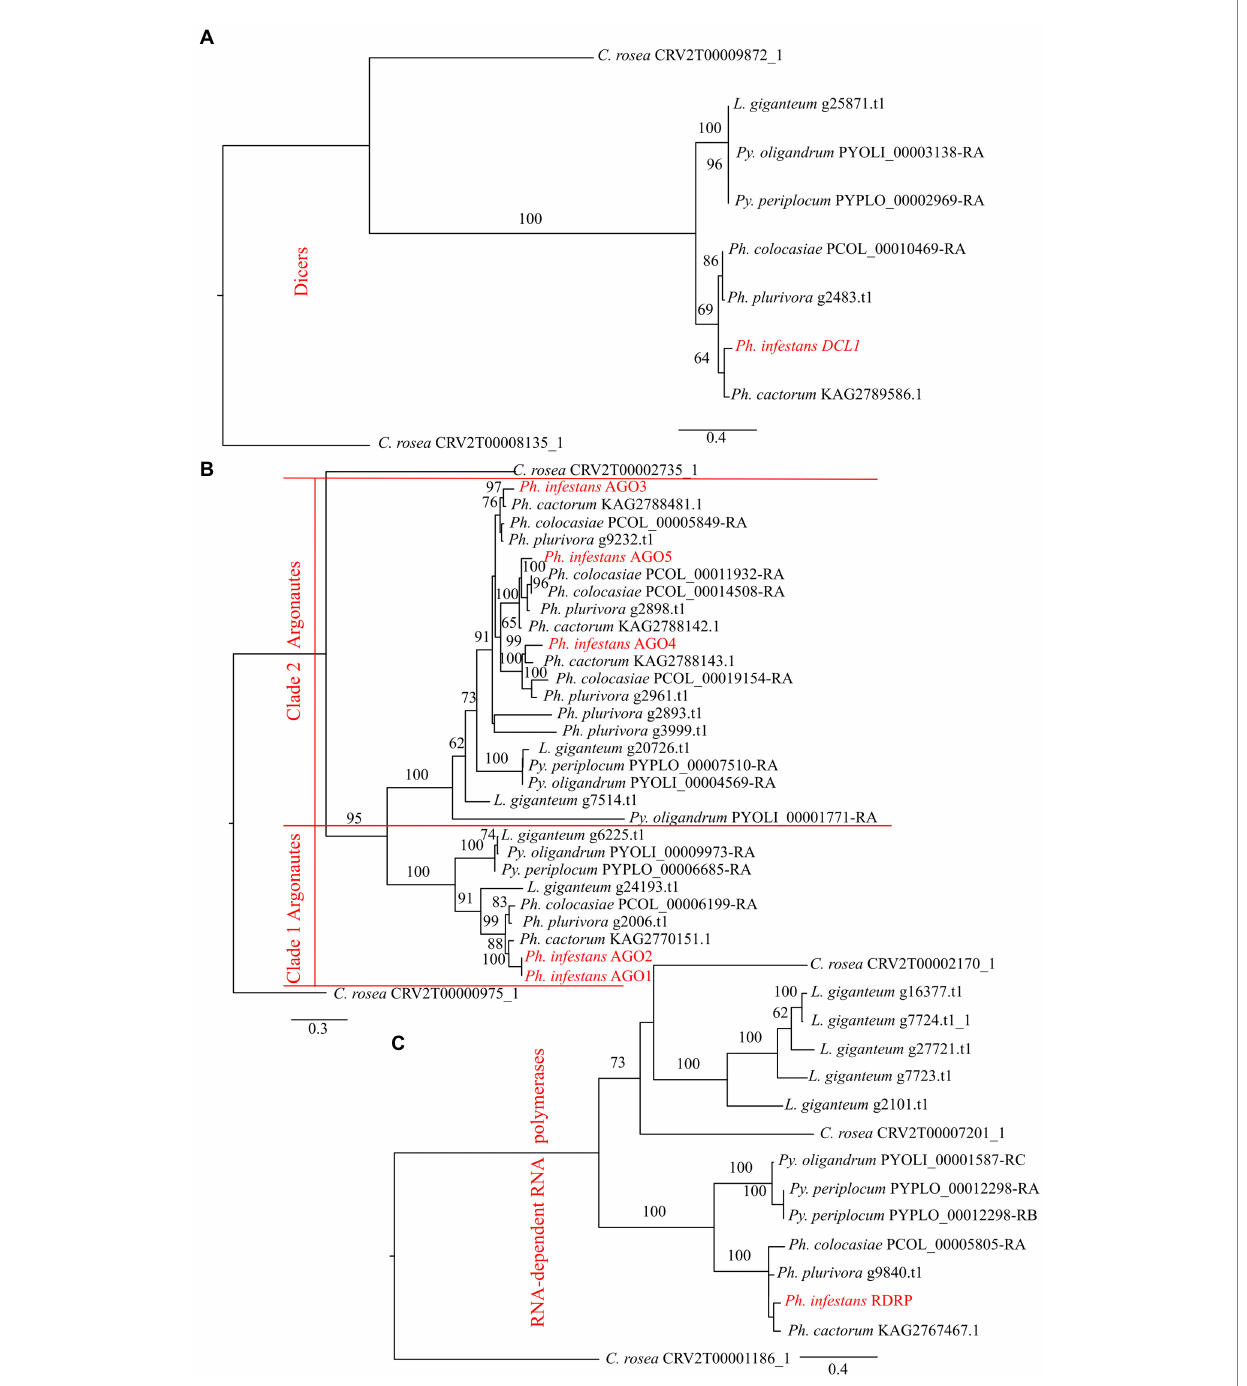
FIGURE 2 Phylogenetic tree illustrating phylogenetic relationships of: DCL proteins (A) , AGO proteins (B) and RDRP proteins (C) . The two AGO clades are separated by red lines. Bootstrap support ( ≥ 60%) values from 1,000 iterations are associated with